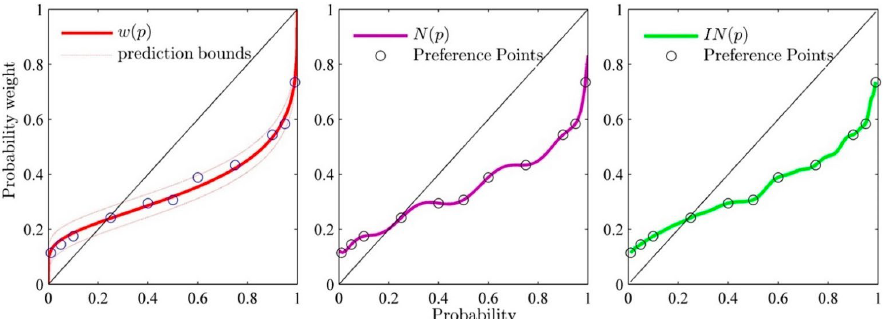
Figure 10. PWF curves based on aggregate data